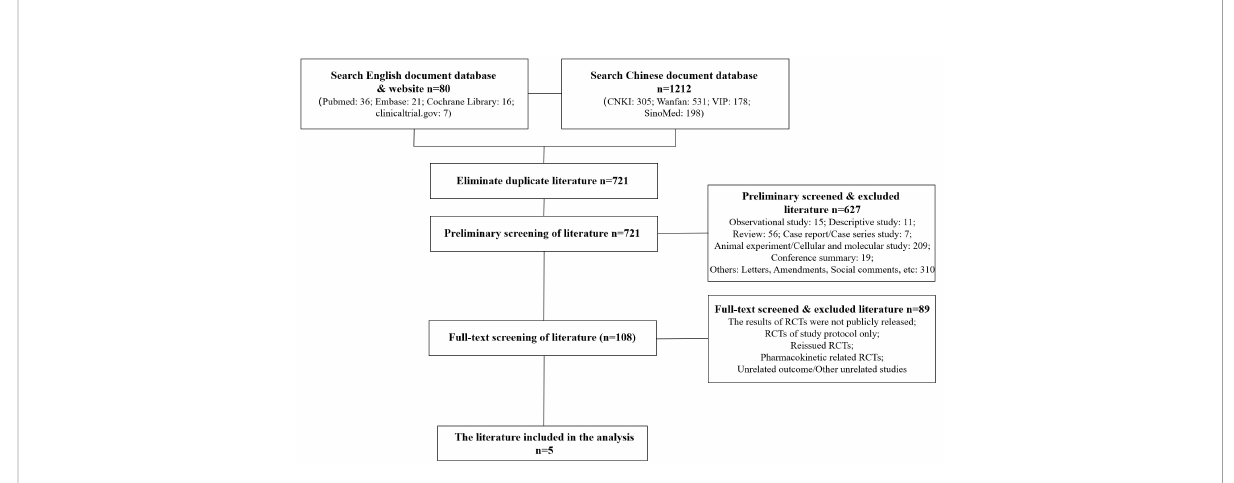
FIGURE 1 Literature screening process and